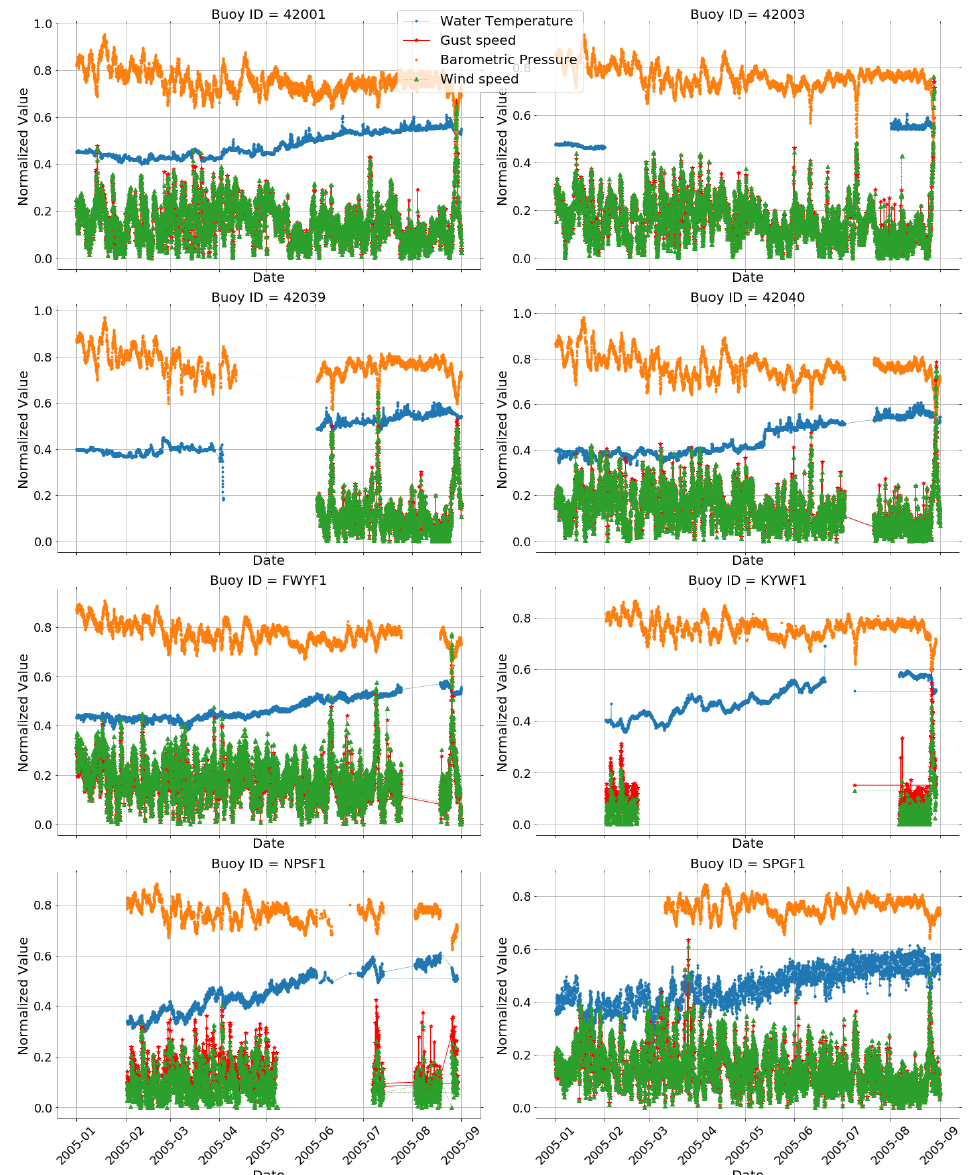
Figure 6. Sample data from buoys 42001, 42003, 42039, 42040, FWYF1, KYWF1, NPSF1, and SPGF1 after interpolation. Attributes shown: Water temperature (WTMP), Gust speed (GST), Barometric Pressure (BAR), and Wind speed (WSPD).